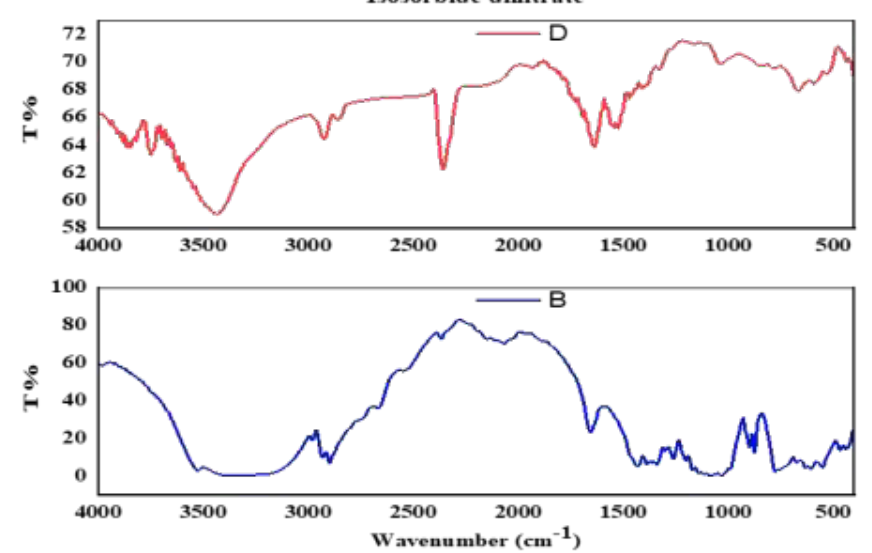
Figure 9: FTIR spectrum for Isosorbide dinitrate (blue line) and after adsorption on an aluminum surface, a film is formed (red line 200 ppm).